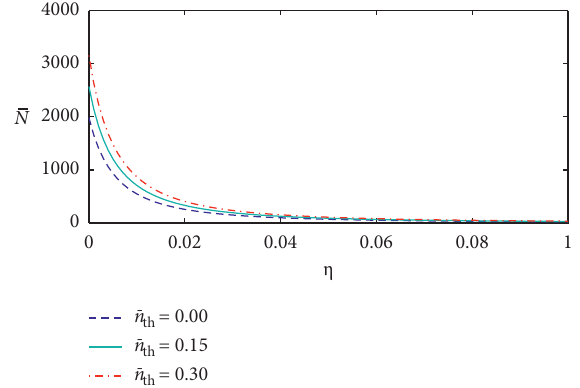
Figure 13: Plots of the mean number of photon pairs (equation (35)) versus η for A � 100, κ � 0 . 8, ε � 0 . 0 and for different values of n th � 0 .